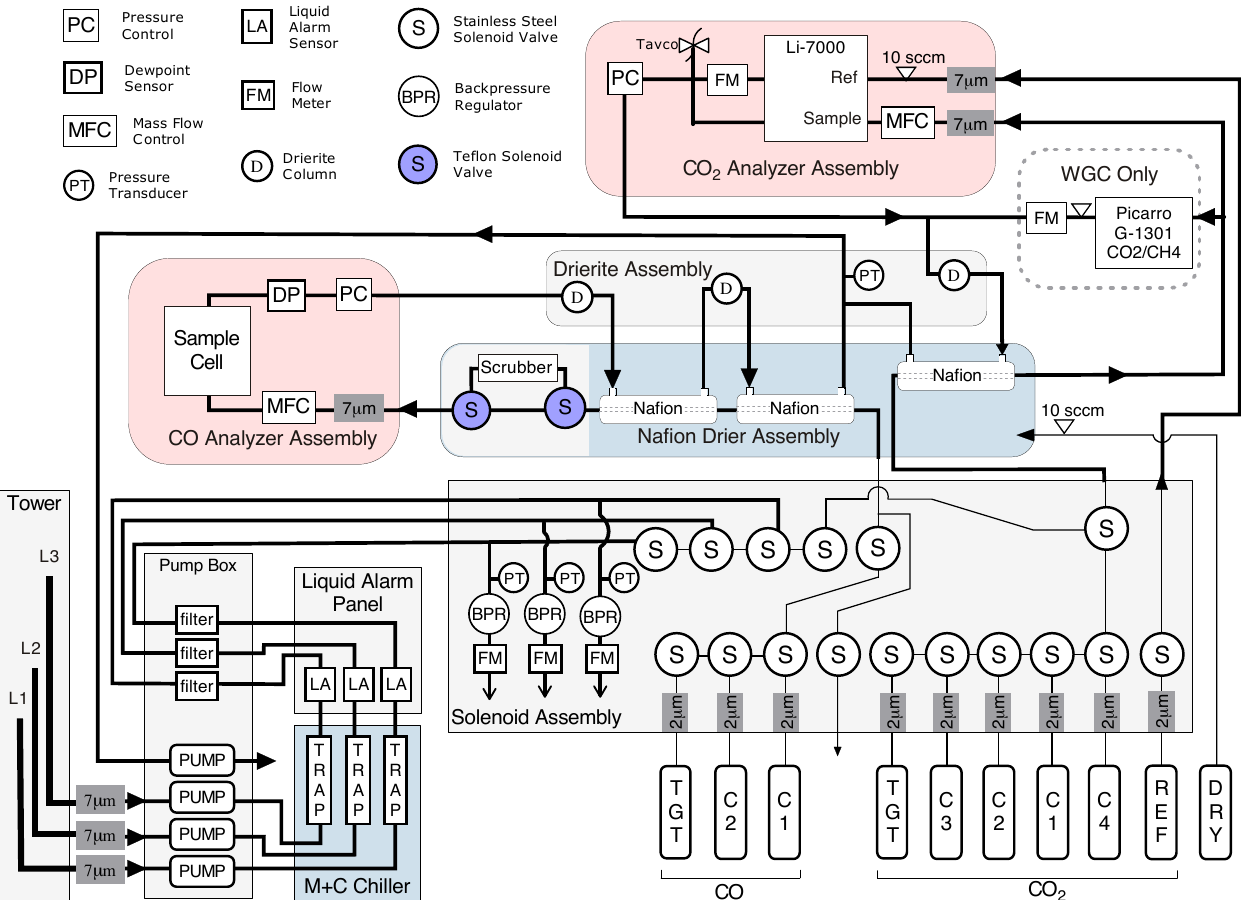
Fig. 1. Schematic diagram of the NOAA ESRL Tall Tower CO 2 /CO analysis system. The Picarro G-1301 analyzer is only included at the WGC tall tower site (Walnut Grove, CA). Line thickness indicates tubing diameters of 0.125, 0.25, and 0.375in. (0.3175, 0.635, 0.9525cm). Pink and blue shading indicate heated and cooled enclosures. Photos are provided in the supplementary